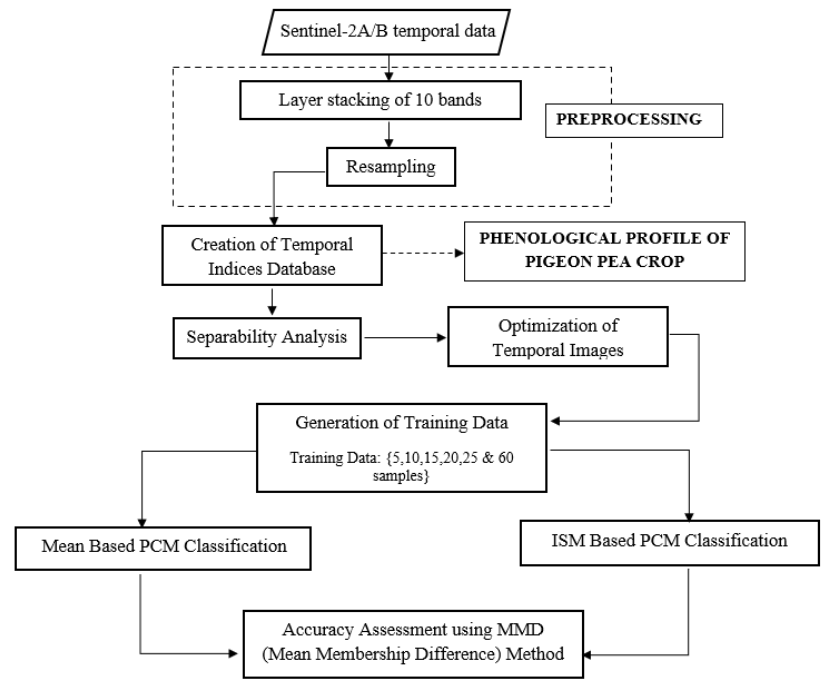
Figure 2. Proposed Methodology of research work.